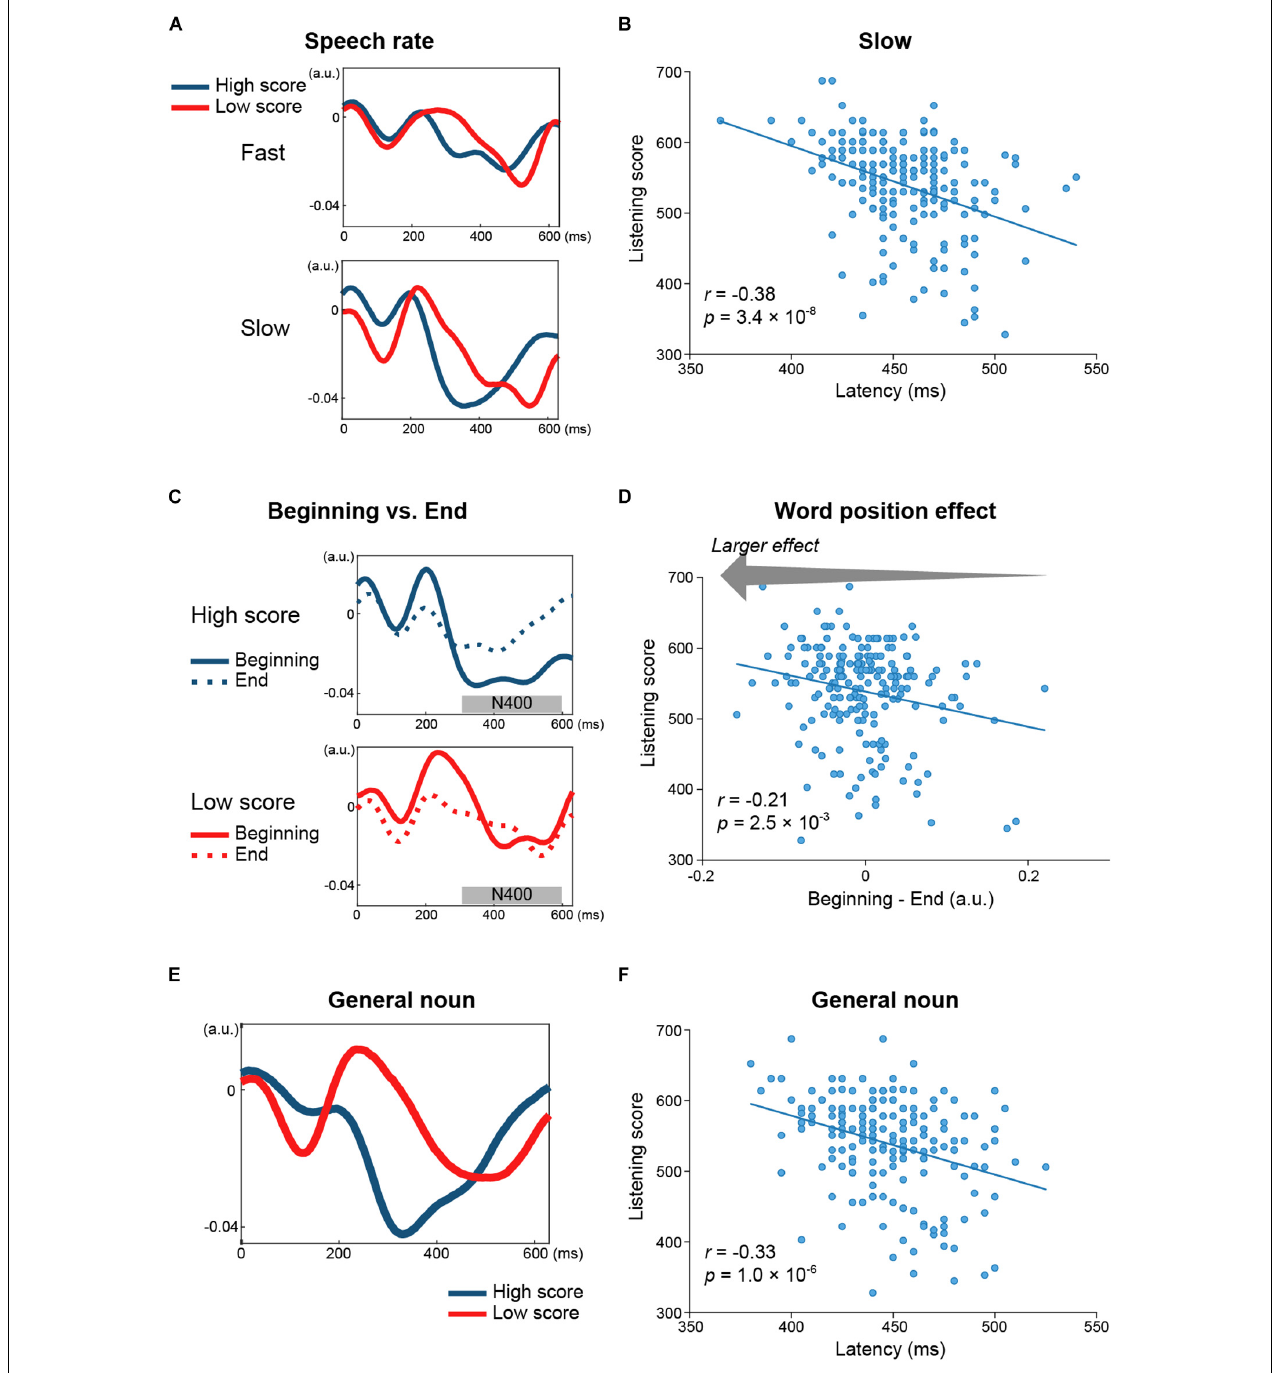
FIGURE 4 | Relationship between the N400 and English proficiency, estimated separately for speech rate, parts of speech, and word position. (A) Grand-averaged TRFs (Cz) for words spoken at a fast (up) and slow (bottom) speech rate across 49 participants with higher listening scores (blue) and across 51 participants with lower scores (red). The N400 peak latencies differed between the two groups for both speech rates. (B) Negative correlation between N400 peak latencies for slow speech (Pz) and the listening scores. (C) Grand-averaged TRFs (Pz) for general nouns in participants with higher (blue) and lower (red) listening scores showing clear between-group differences in N400 peak latencies. (D) The N400 peak latencies of general nouns (Pz) were negatively correlated with the listening scores. (E) Grand-averaged TRFs (Pz) for words at the beginning (solid line) and end (dashed line) of the speech stimuli in participants with higher (blue) and lower (red) listening scores. The difference in N400 amplitudes between the beginning and end positions of speech stimuli (i.e., the word position effect) was larger in the group with higher listening scores than in the group with lower listening scores. (F) The word position effect was negatively correlated with the listening scores. This indicated that the N400 amplitude was lower in the end position than in the beginning position, which was to a larger extent in the participants with higher proficiency.